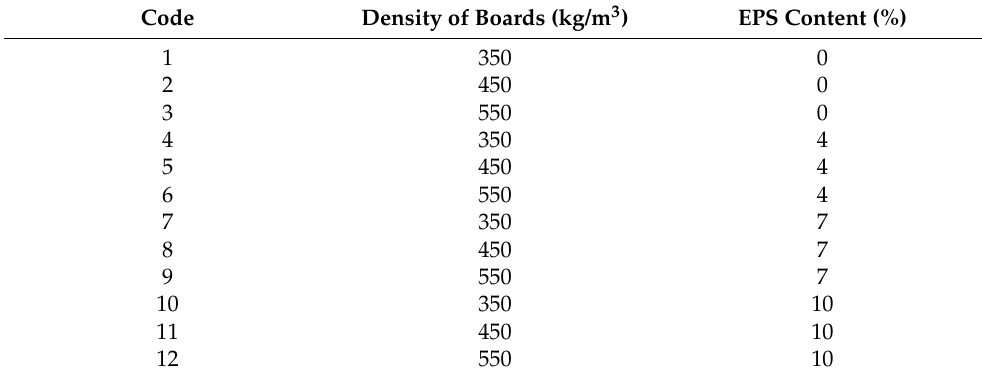
Table 1. List of boards manufactured and symbols used.